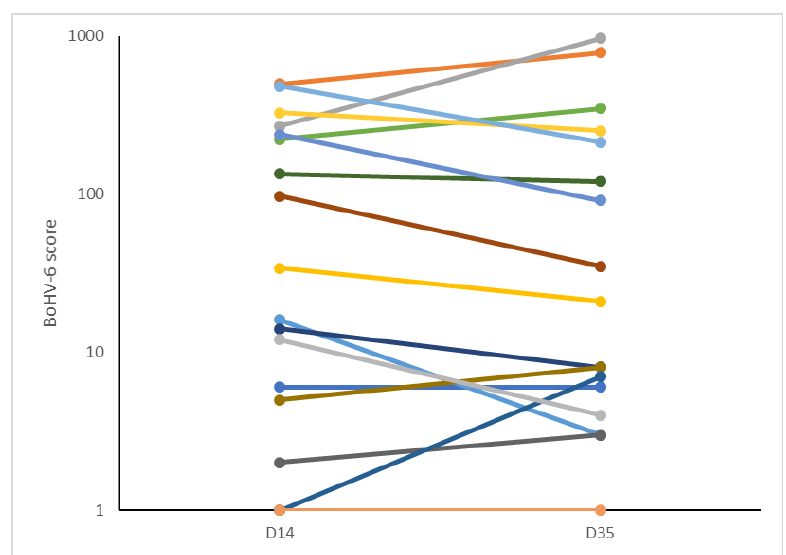
Figure 2. Log10 BoHV-6 scores in 17 cows in which repeat samples of leukocytes were analyzed at both 14 and 35 days in milk (DIM).